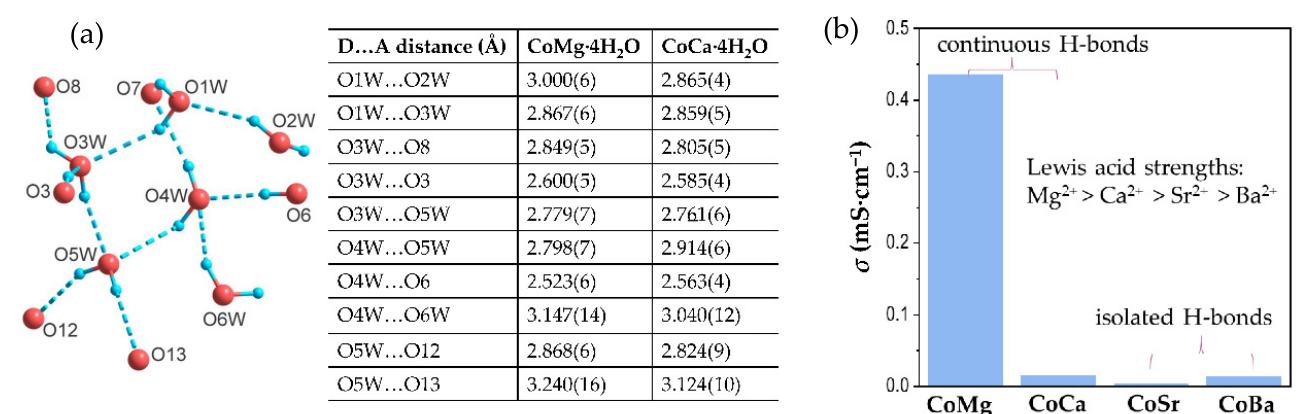
Figure 8. ( a ) Identical hydrogen-bonding networks of CoMg · 4H 2 O and CoCa · 4H 2 O . ( b ) Comparison of proton conductivities of all compounds and possible contributing factors.